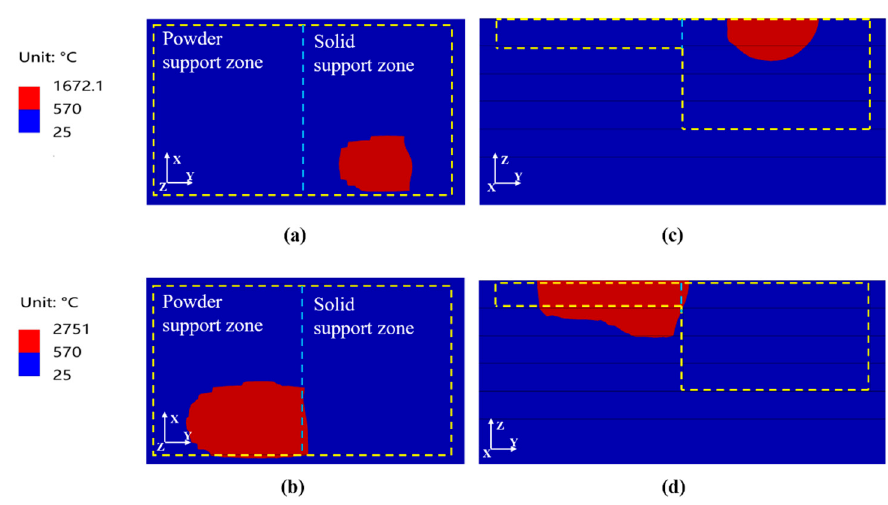
Figure 6. The temperature distribution of layer 1: ( a ) scan of the solid support zone on the X–Y plane; ( b ) scan of the powder support zone on the X–Y plane; ( c ) scan of the solid support zone on the Y–Z plane; and ( d ) scan of the powder support zone on the Y–Z plane.